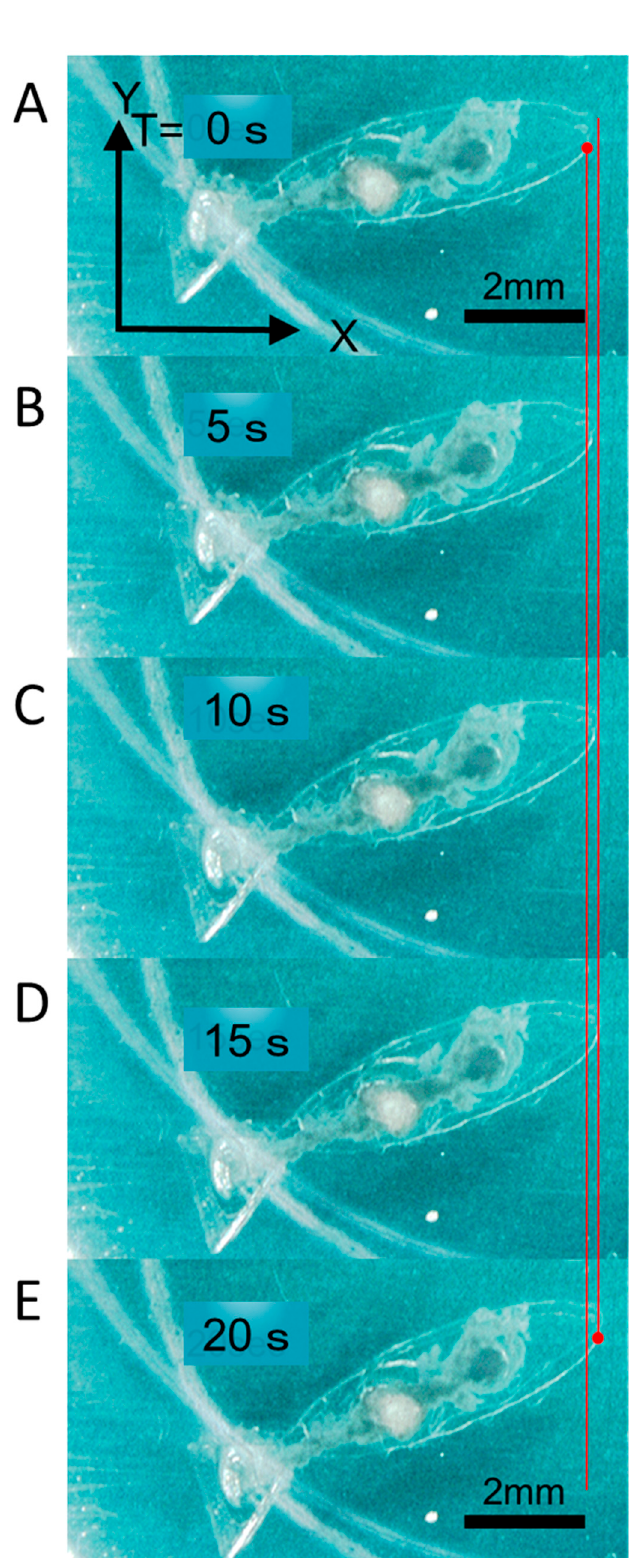
Figure 8. Images showing the swimming of the insect muscle powered robot. ( A – E ) The images were captured from the video recording of S2 at 5 s intervals, and the robot swam for a distance of about 400 µ m at a velocity of 11.7 µ m / min. The left and right vertical red lines indicate the initial and final positions in the video, respectively.